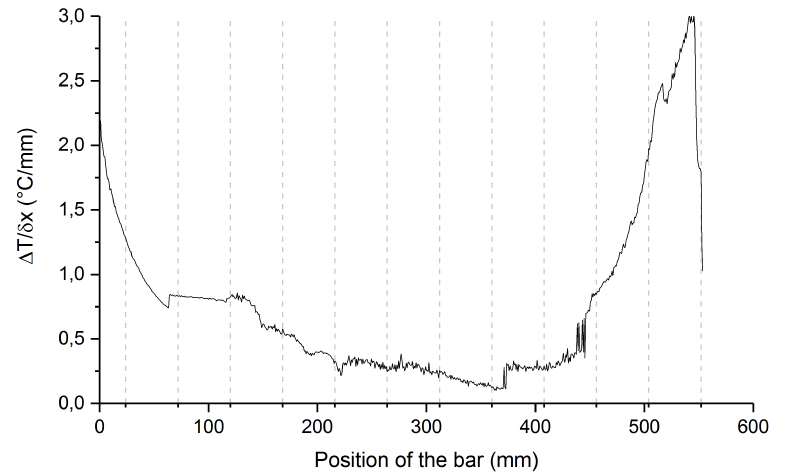
Figure 11. Temperature gradient according to the position in the